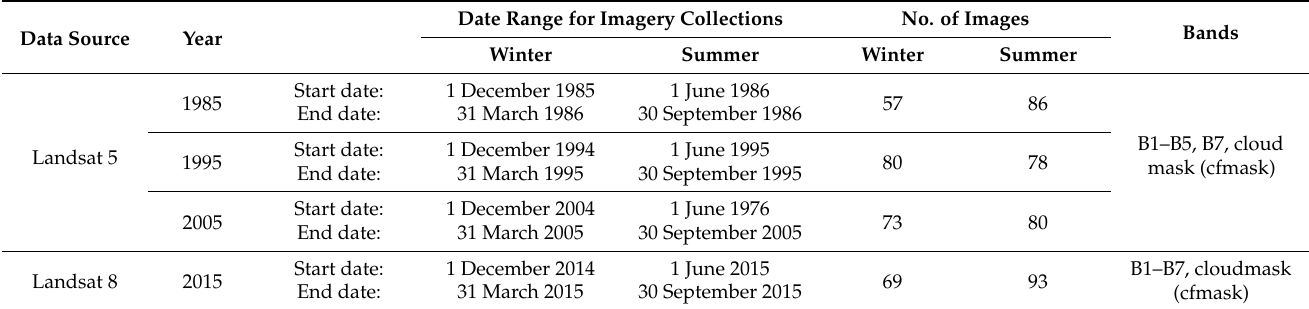
Table 1. Temporal coverage of Landsat imagery used for mapping the extent and loss of the Sand Shinnery Oak Prairie Ecoregion, New Mexico and Texas Southern High Plains,